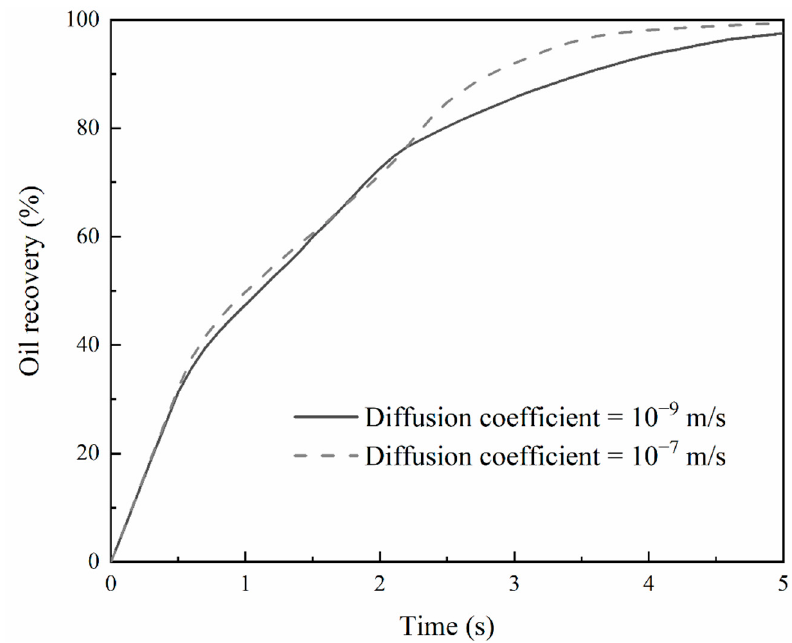
Figure 9. Oil recovery at the diffusion coefficient of 1 × 10 − 9 and 1 × 10 − 7 m/s under the miscible condition.